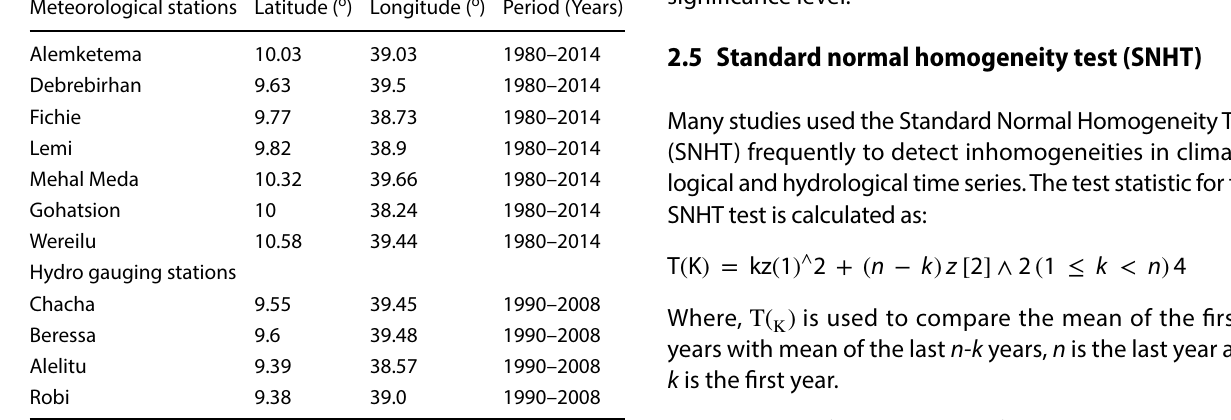
Table 1 Descriptions of meteorological and hydro-gauging stations Meteorological stations Latitude ( o ) Longitude ( o ) Period